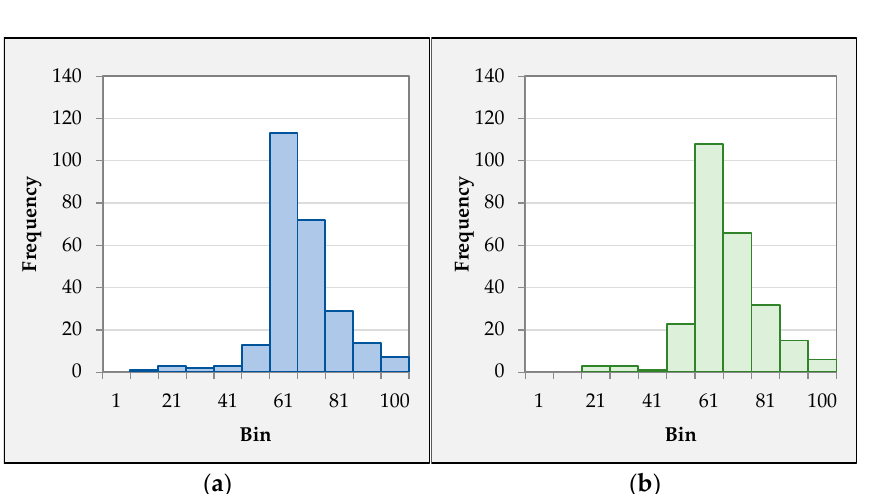
Figure 6. The histograms of overall assessments. ( a ) Mathematics course; ( b ) Statistics course.